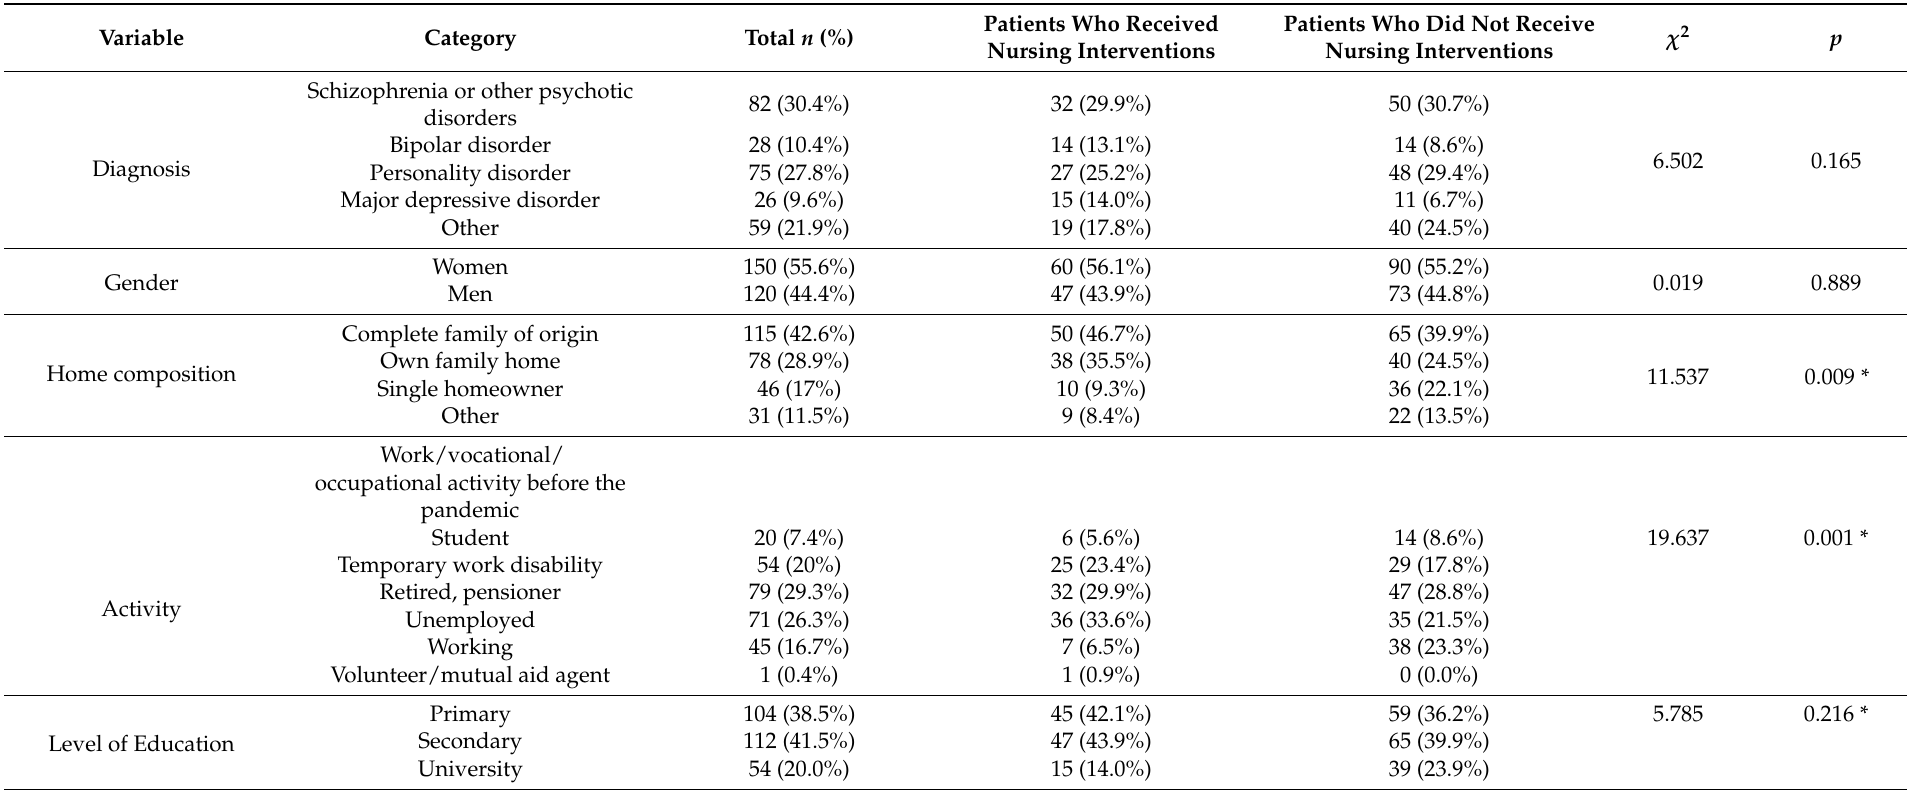
Table 1. Description of sociodemographic